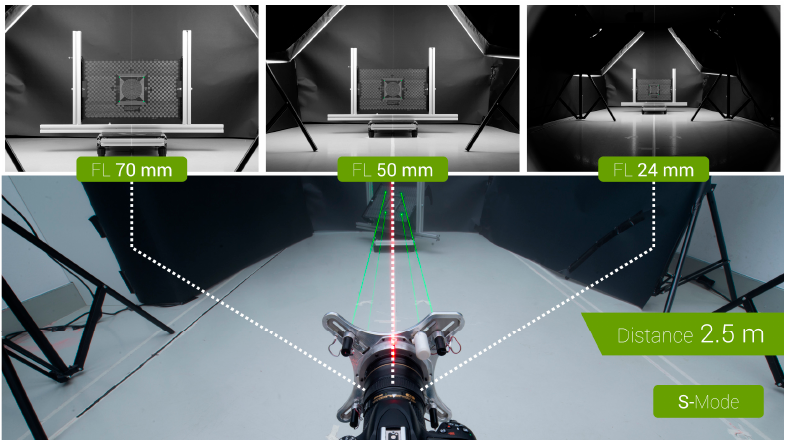
Figure 6. Test setup used for the verification tests, with three example verification pictures at the 2.5 m working distance in the S-mode, showing the effect of using different focal lengths.